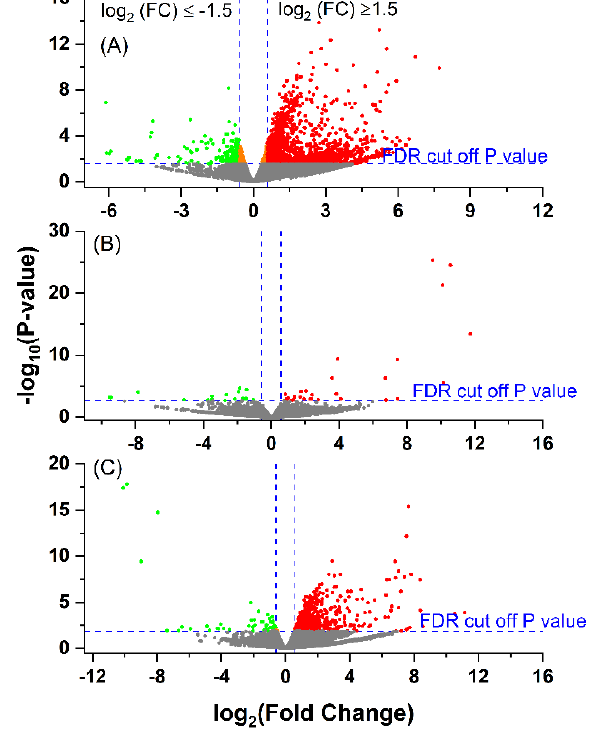
Figure 1. Volcano plot showing the gene expression profiles following an E. coli mastitis infection between: (A) EARLY ( n = 6) and Control (CONT, n = 6); (B) LATE ( n = 3) and CONT and (C) EARLY and LATE. The reads were quantified as reads per kilobase million (RPKM) and normalised with trimmed mean and Z-score across all samples. The fold changes were log2-tramsformed. The p - values were transformed with -log10. Cut-off point was p < 0.05 and absolute fold change ≥1.5. The cut-off p (raw) value for false discovery rate control (FDR) at p < 0.05 was 0.0275 for EARLY vs. CONT, 0.0019 for LATE vs. CONT and 0.0134 for EARLY vs. LATE. The green dots indicate significantly down-regulated genes; the red dots indicate significantly up-regulated genes; and the orange dots are the genes with FDR p < 0.05, but with absolute fold changes <1.5.